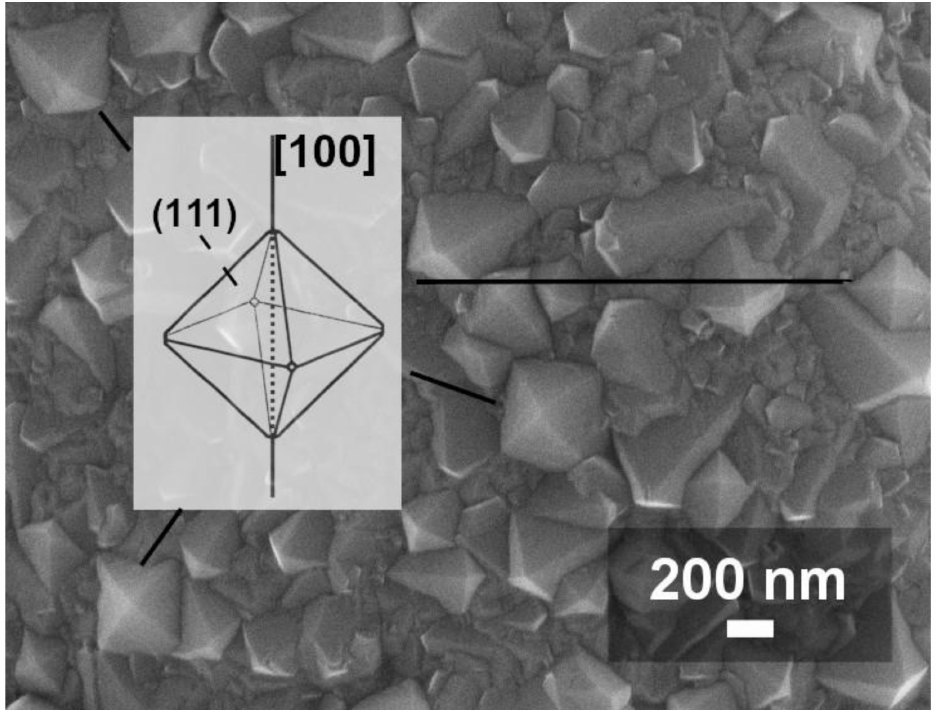
Figure 2. Typical SEM image of polycrystalline diamond films with predominantly triangular (111) faces, which were obtained on substrates that were the farthest from the hot filaments. The inset shows one of the two limiting shapes for an ideal single-crystal diamond based on growth along the <100> and <111> crystal directions. See the text for